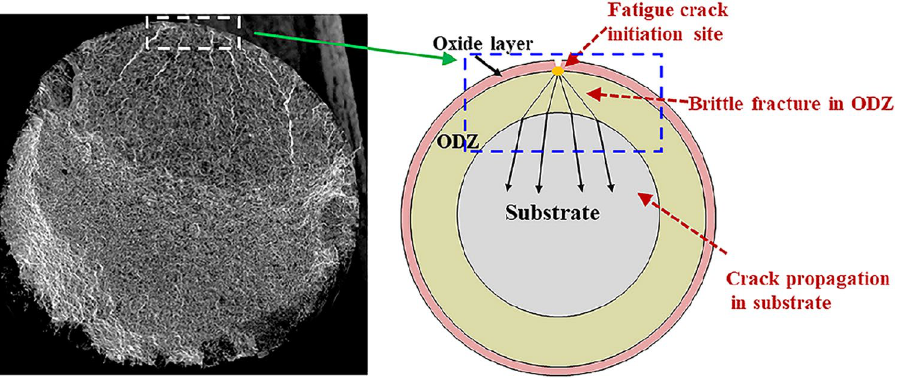
Figure 8. Schematic showing fatigue fracture process in USDR-OBD